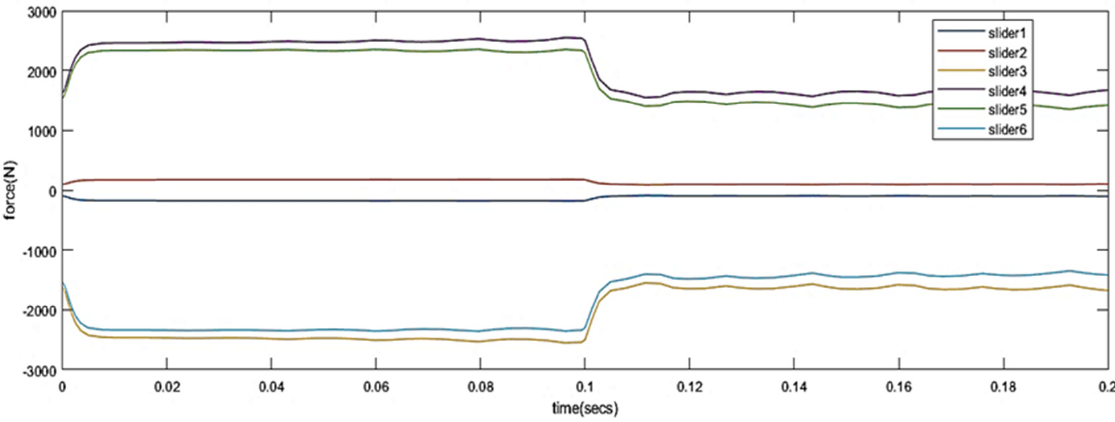
Figure 11. Second dynamic simulation result.